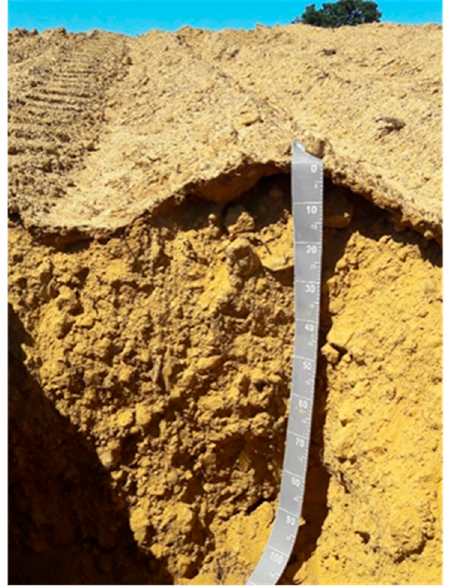
Figure 2. Strong soil crusting on a silty loam soil, with loose structure, previously tilled for a hazelnut tree field preparation in Mediterranean area. The SOM content of this soil was less than 0.1%.